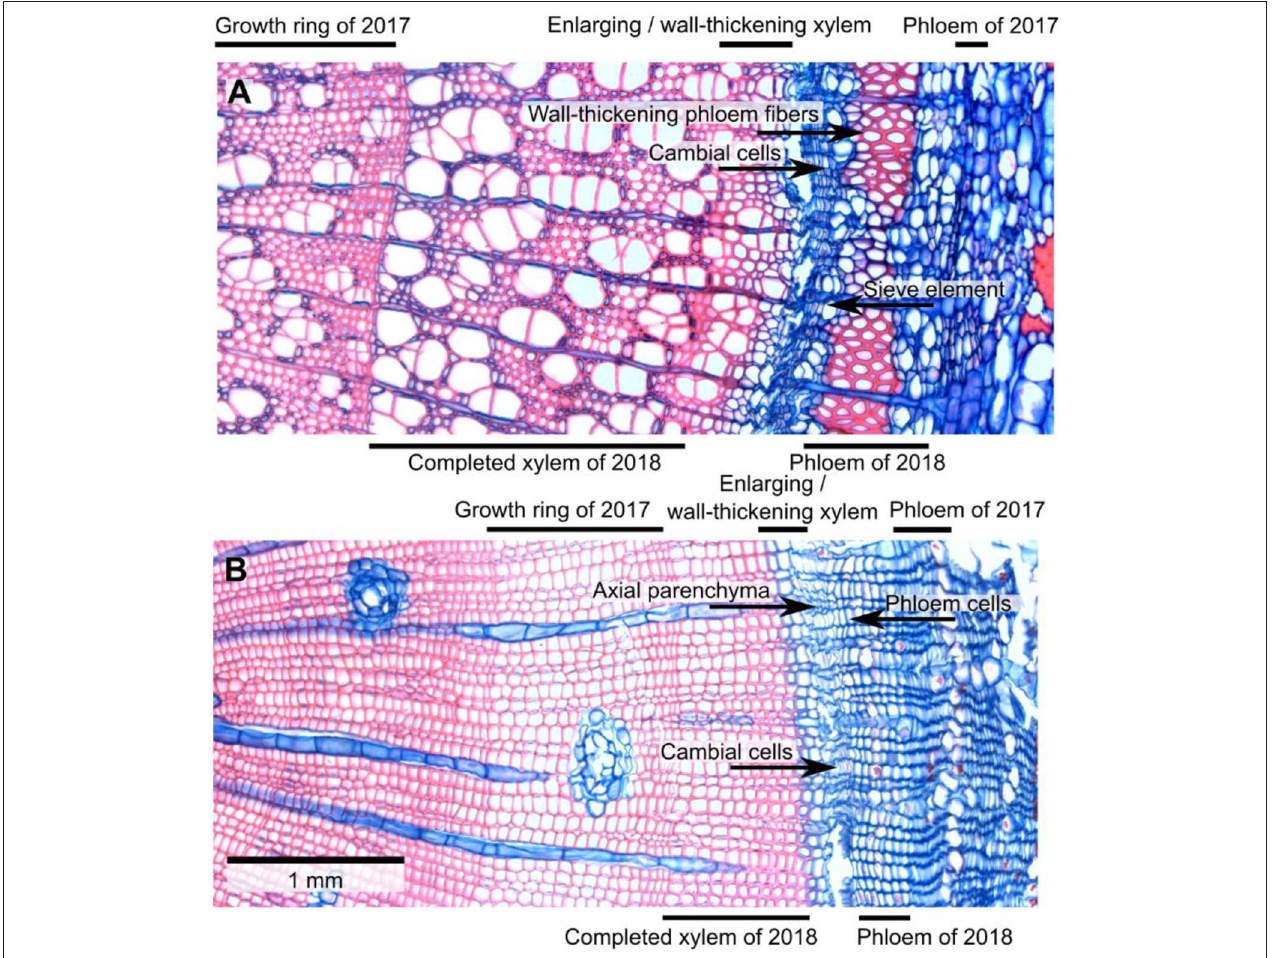
FIGURE 1 | Micro-sections of trembling aspen (A) and lodgepole pine (B) branches collected on June 17, 2018. Red stain is from safranin and indicates lignified tissue. Blue stain is from astra blue and indicates tissue that has not (yet) been lignified. In aspen, mature fibers and vessels are stained red while rays and axial parenchyma cells are blue. There was a narrow zone near the cambium in which the color of fiber and vessel walls changed from blue to red; i.e., cell walls underwent lignification. The 2018 phloem increment already had some large, more or less circular sieve tubes and a distinct layer of fibers. By contrast, sieve tubes that were formed in the previous year (2017) looked crushed. In lodgepole pine, there was a very narrow band of enlarging/wall-thickening tracheids near the cambium. Phloem cells produced in 2018 looked functional while phloem formed in the previous year appeared